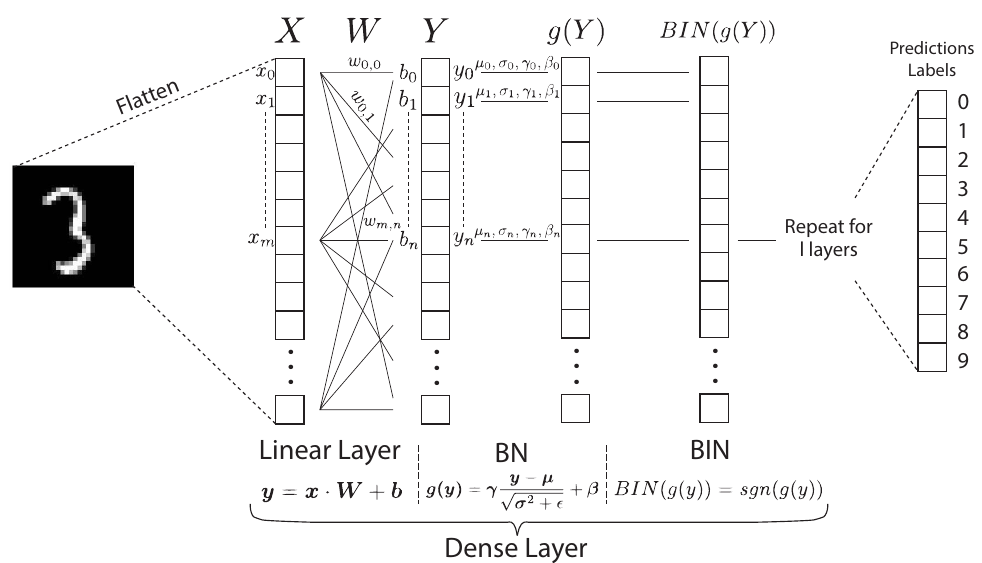
Figure 2: Baseline BNN-MLP dense layer architecture. Note that the last layer does not use the activation function to generate continuous score